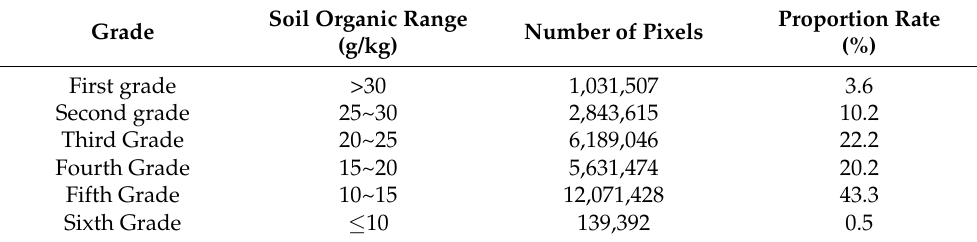
Table 1. Statistical results of soil organic matter classification in Southwest Shandong, China.